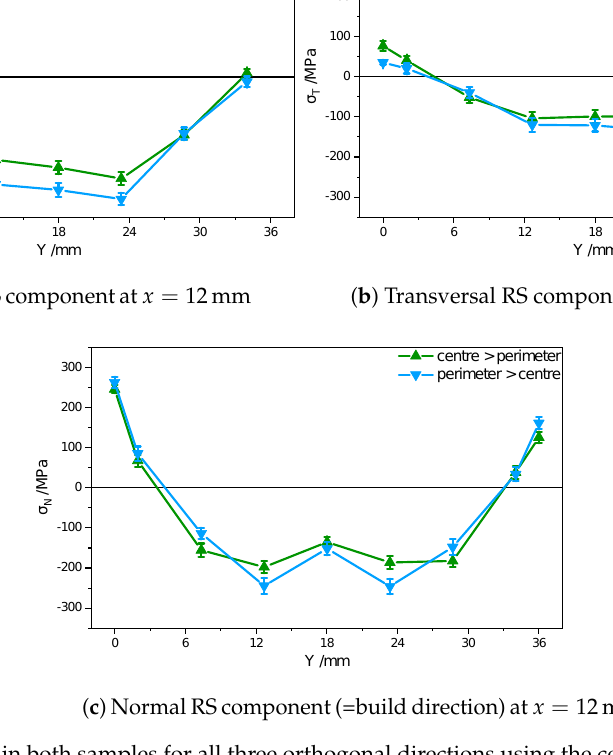
Figure 9. Line scans in both samples for all three orthogonal directions using the combined data from ND and lab